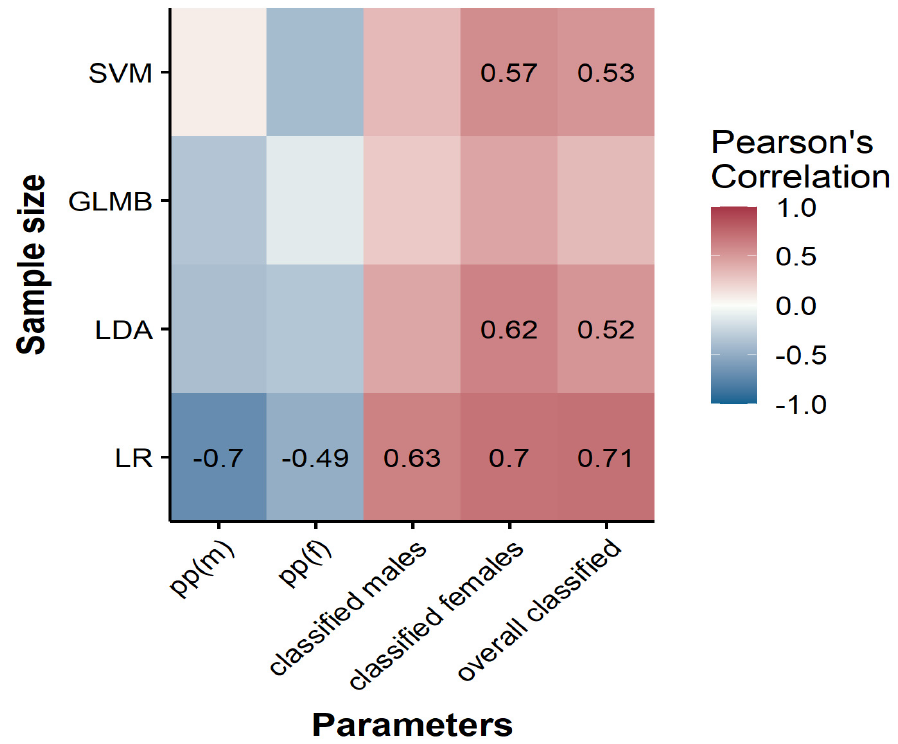
Figure 1. Correlation plot between the sample size and its effect on pp cutoff values and the percentage of classified males and females, as well as the overall classified individuals. Correlation coefficients are shown for statically significant values only at p < 0.05.